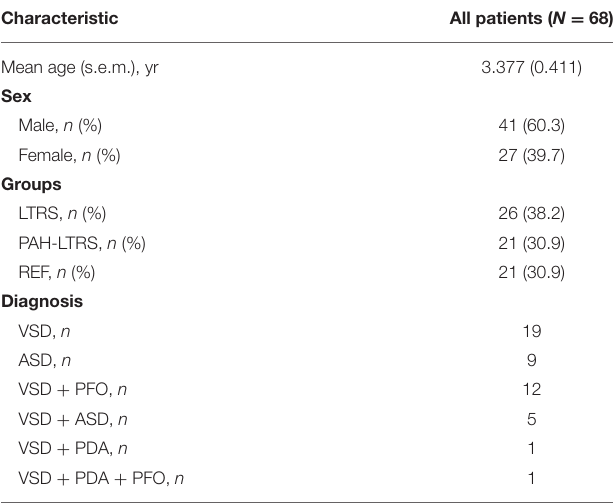
TABLE 1 | Characteristics of